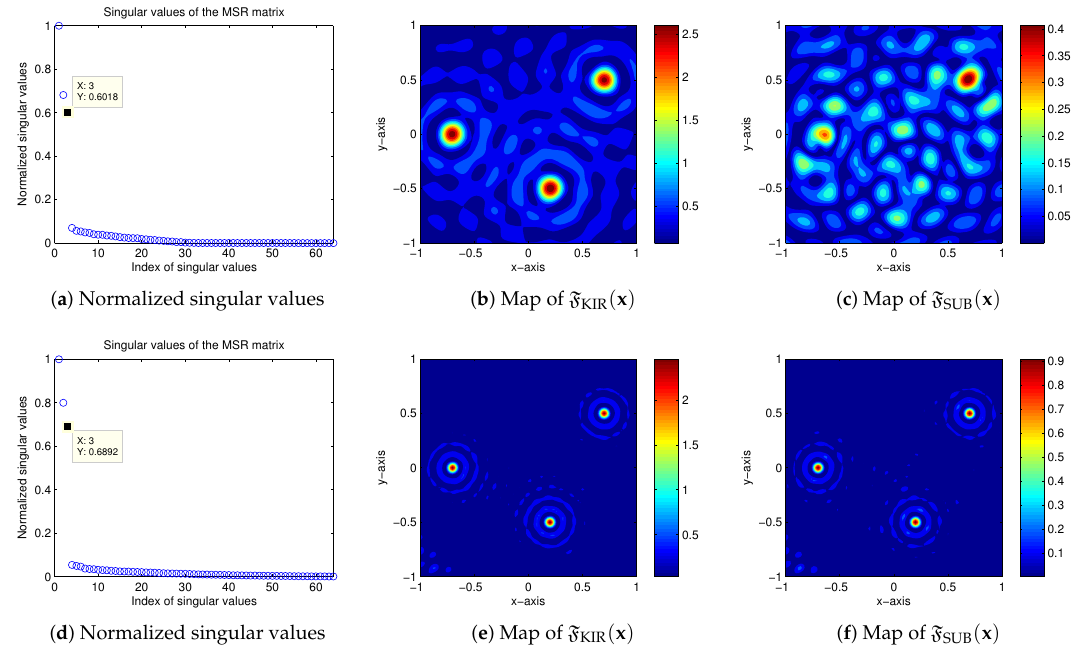
Figure 2. (Example 1: Case 1) Distribution of normalized singular values, maps of F KIR ( x ) and F SUB ( x ) for λ = 0.7 ( top line ) and λ = 0.2 ( bottom line